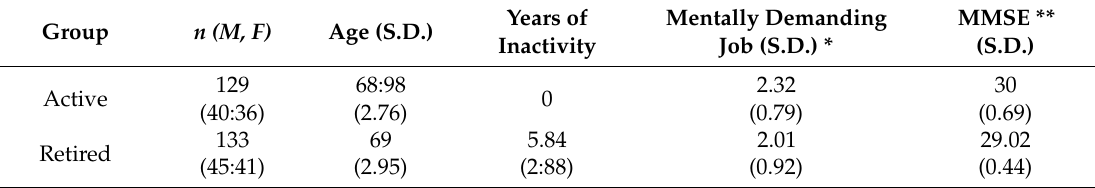
Table 1. Participant